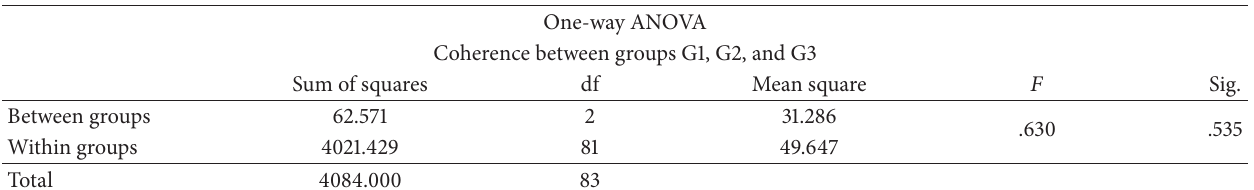
Table 3: One-way ANOVA analysis of the coherence between groupings of microbial communities and between species. One-way ANOVA Coherence between groups G1, G2, and